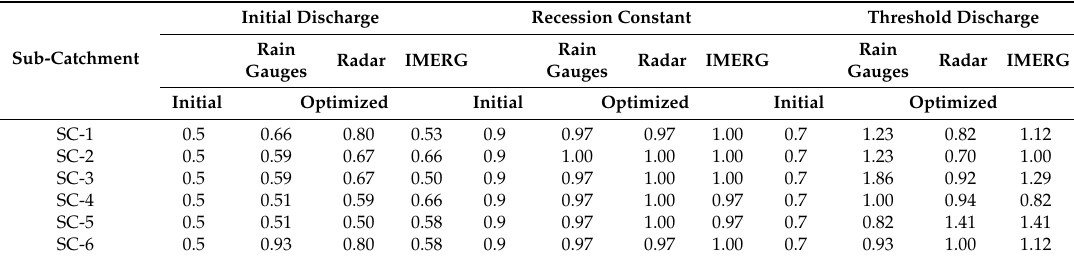
Table 10. Calibrated model parameters for Recession Base flow